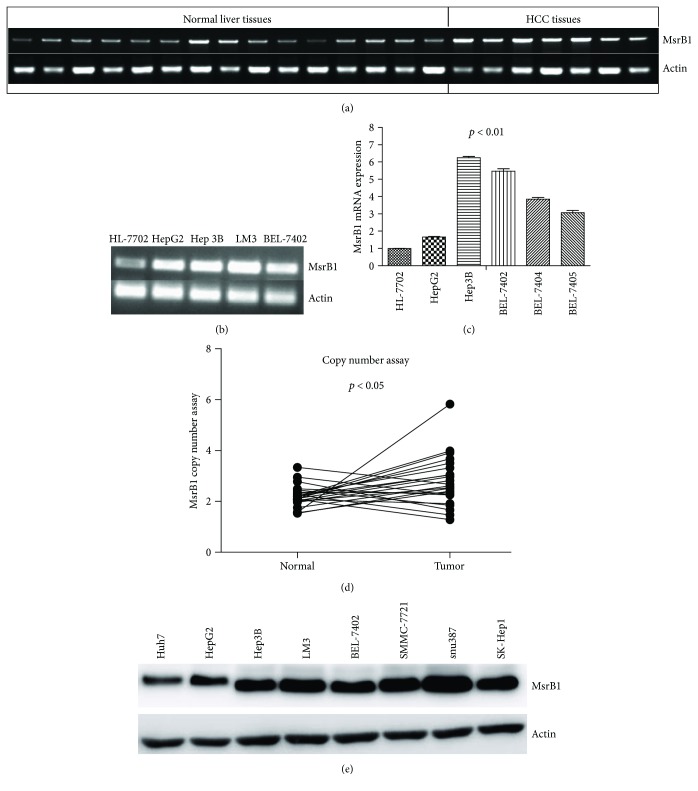
Expression of MsrB1 in tissues and cell lines of HCC. (a) MsrB1 mRNA expression was elevated in 6 HCC tumors than in 9 normal liver tissues detected by RT-PCR. (b) MsrB1 mRNA expression was increased in HepG2, Hep3B, LM3, and BEL-7402 cell lines than in HL-7702 detected by RT-PCR. (c) MsrB1 mRNA expression was increased in HepG2, Hep3B, BEL-7402, BEL-7404, and BEL-7405 cell lines than in HL-7702 detected by q-PCR (P < 0.01). (d) The DNA copy number assay showed that the MsrB1 copy number was stepped up in HCC tissues than in adjacent normal tissues. (e) The MsrB1 expression level was increased in HepG2, Hep3B, LM3, snu387, SK-hep1, and BEL-7402 and decreased in Huh7 and SMMC-7721 detected by Western blotting.